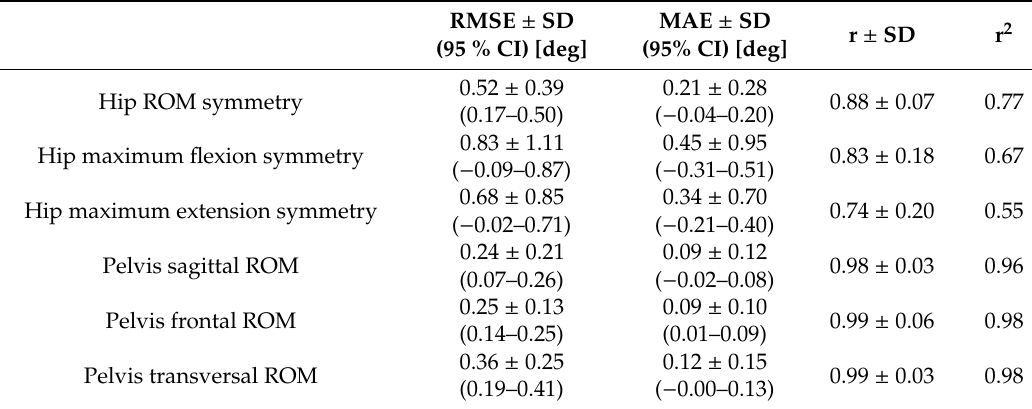
RMSE ± SD MAE ± SD (95 % CI) [deg] (95% CI) [deg] 0.52 ±